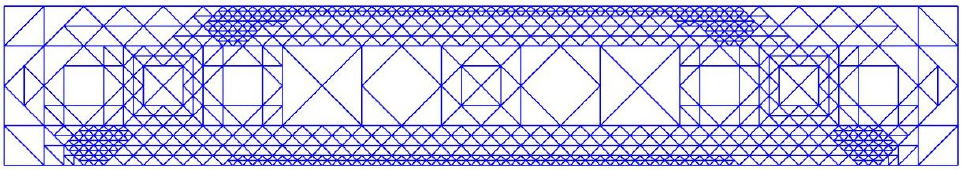
Figure 8. Final part with optimised infill using refinement technique with threshold stress = 10 MPa and minimum length of a side of the infill design (L) ≥ 2.4 mm as stopping criteria (infill density =